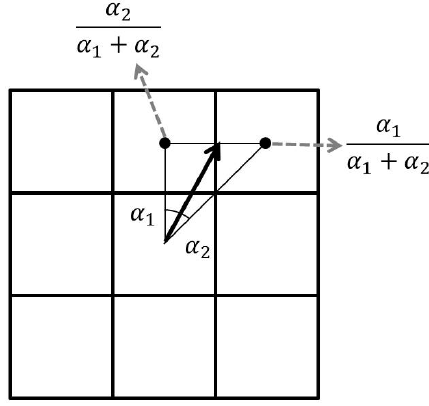
Fig. 7. Concept diagram of D-infinity method. lower elevations than the initial one. The pattern, of course, becomes more strongly concentrated toward the steepest downslope path. Equation (5) expresses the relative amounts for the downhill